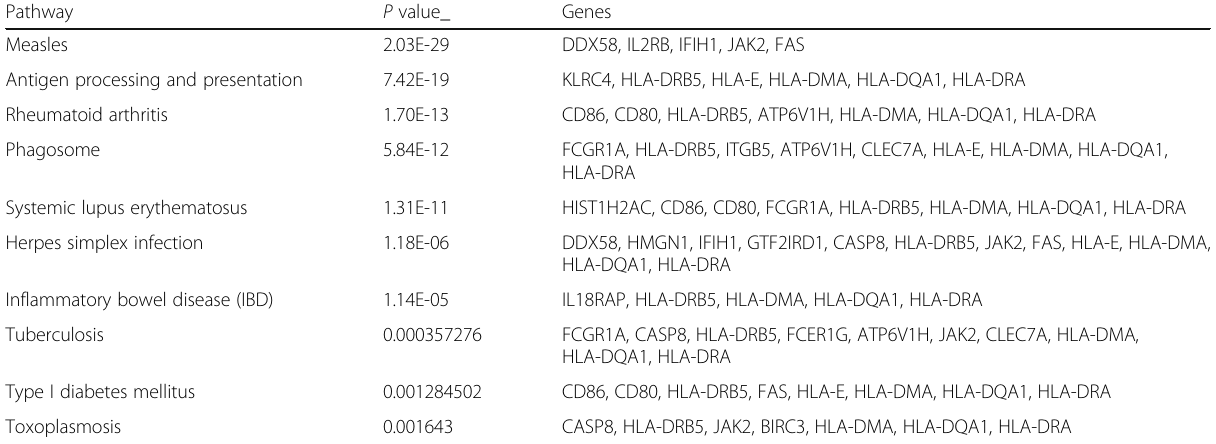
Table 2 Selection of risk-related pathways Pathway P